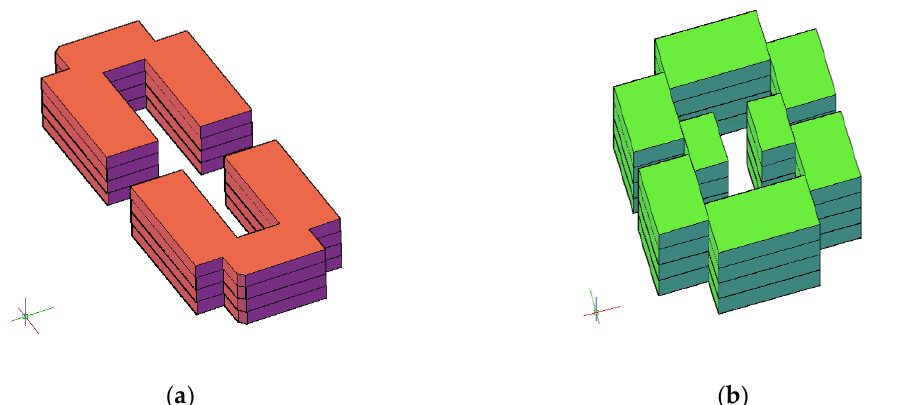
Figure 10. Three dimensional CAD plots for: ( a ) a typical clustered four floors housing used in C1DS1 and C2DS1 and ( b ) a typical four floors refined clustered housing used in C1DS2 and C2DS2.